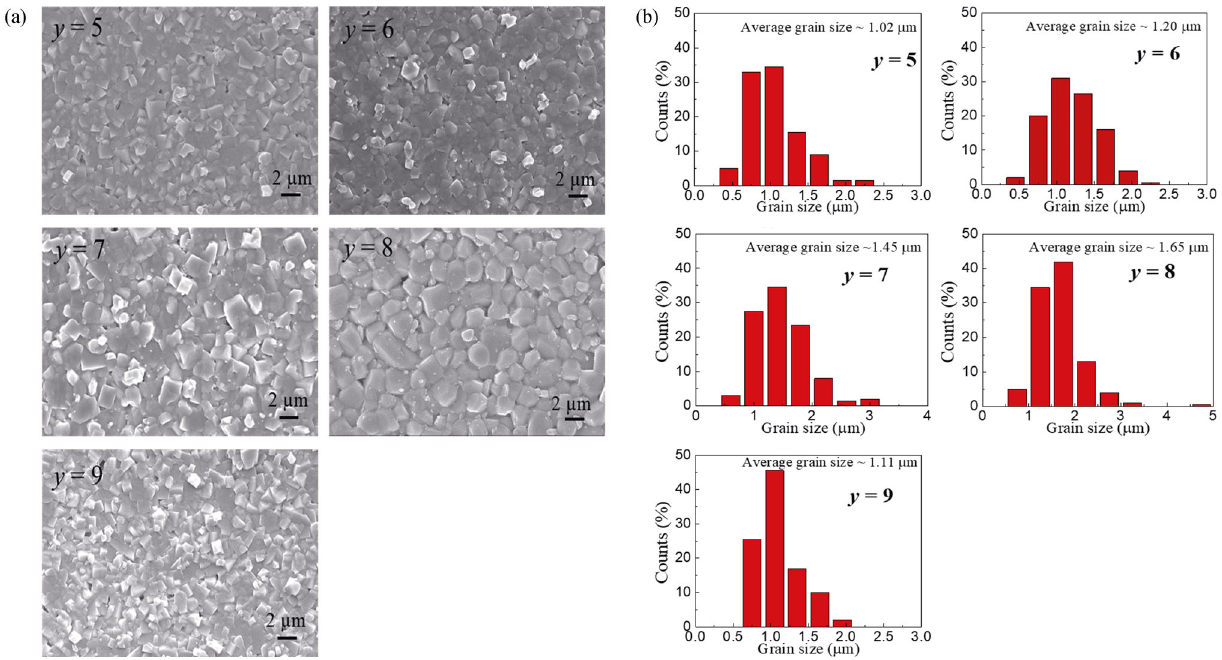
Fig. 1 (a) SEM microphotographs and (b) grain size distributions of KNNT–0.055BZ + 0.03Zr + y Mn ceramics.